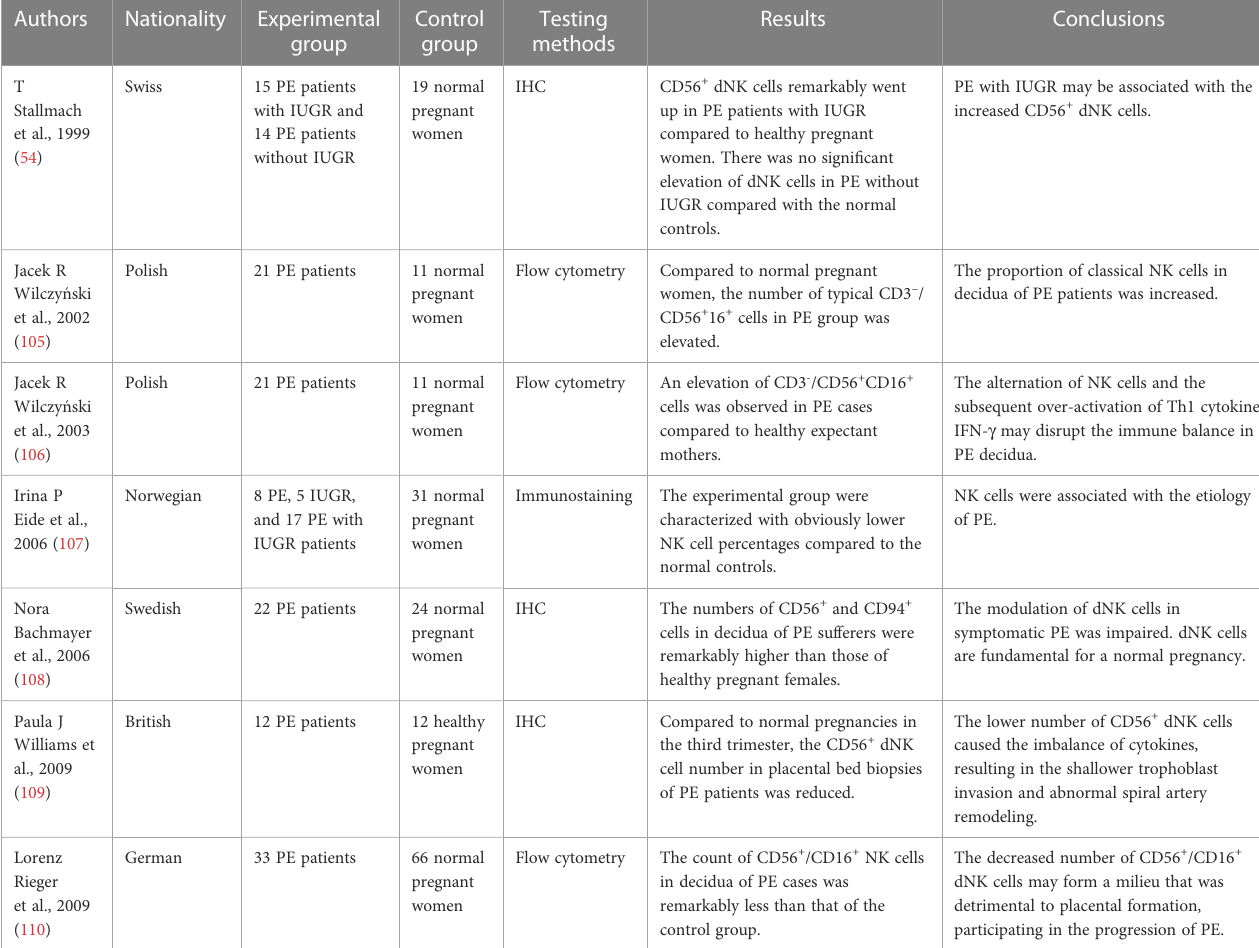
TABLE 2 Studies about dNK cells in PE.